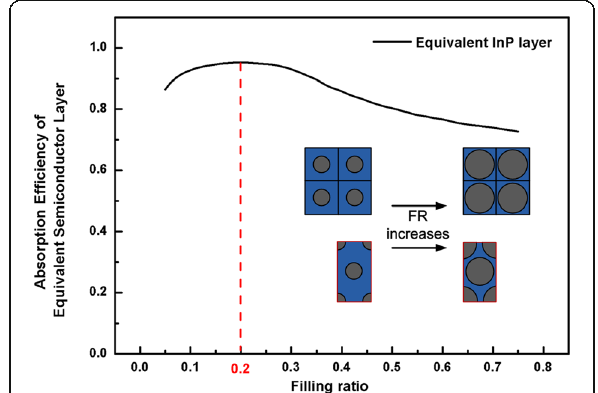
Fig. 4 Absorption efficiency of effective medium layer for InP NW arrays as a function of